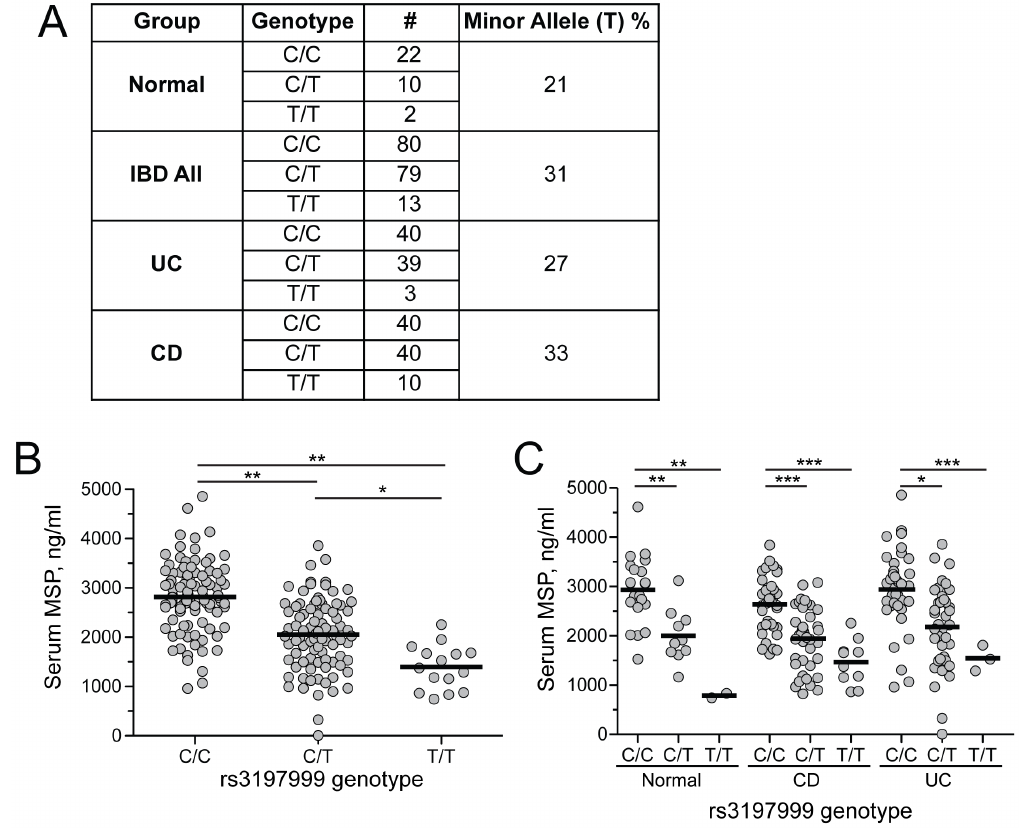
Figure 7. Carriers of the 689C polymorphism have lower quantities of serum MSP. (A) Analysis of rs3197999 alleles in DNA samples from normal, UC, and CD patients. The C allele encodes MSP 689R and T allele encodes MSP 689C. Allele frequency and number are indicated for each group. (B) MSP concentrations in matched serum samples of EMBARK subjects determined by ELISA, with results grouped by rs3197999 genotype. *p , 0.005, **p , 0.0005. (C) Serum MSP concentrations grouped by genotype and disease status. *p , 0.05, **p , 0.005, ***p , 0.0005.